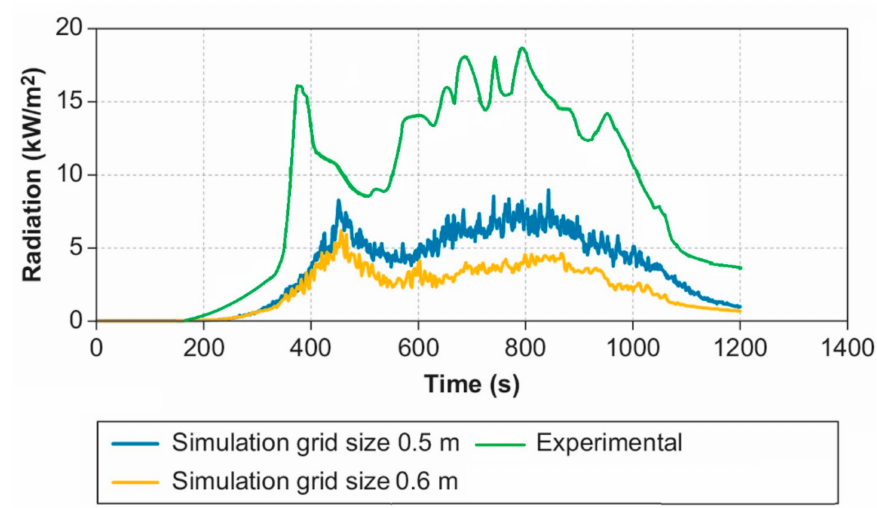
Figure 3. Radiation flux on the ceiling 20 m downstream of the source of fire.